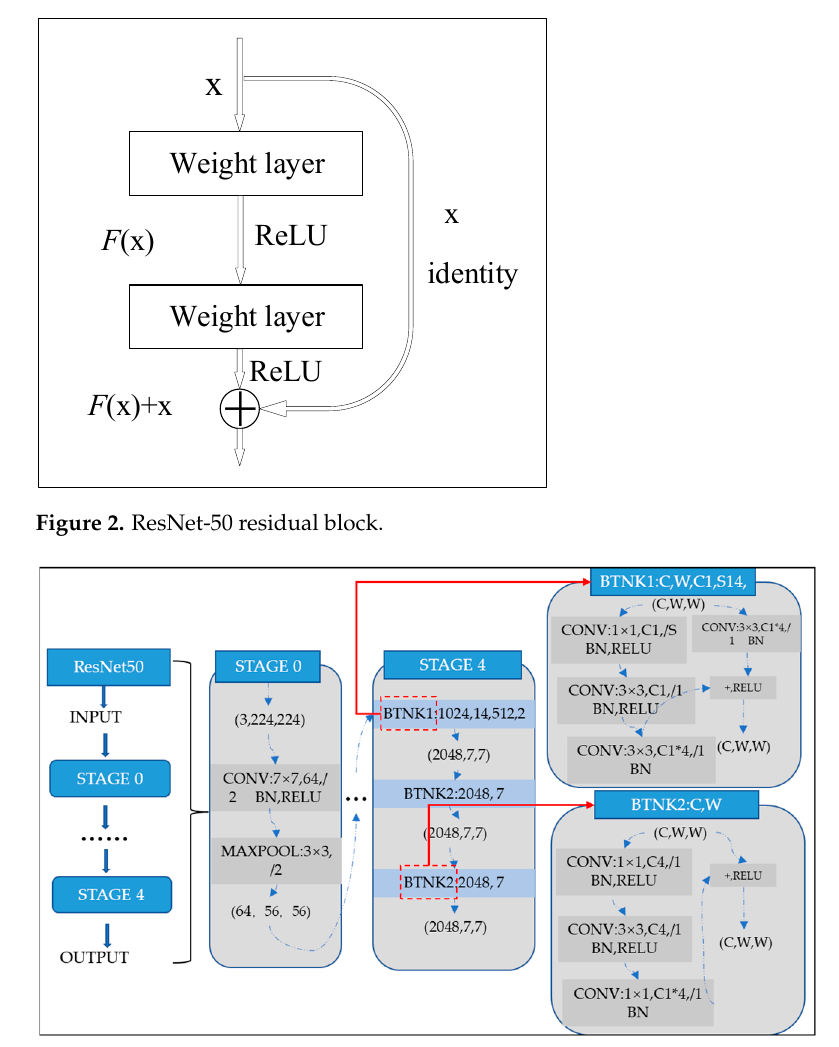
Figure 3. ResNet-50 neural network configuration.